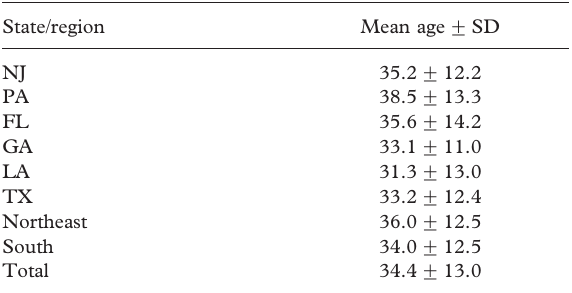
Table III. Mean age in years of study population by state and region